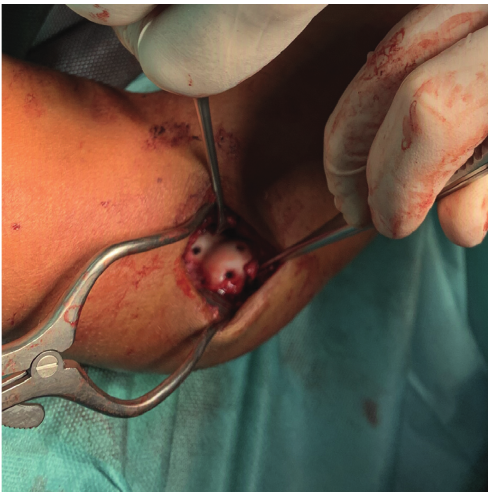
Figure 3: Patient number 4, intraoperative view after definitive fixation (2 × SmartNail in the capitellum and 1 × SmartNail in the trochlea).